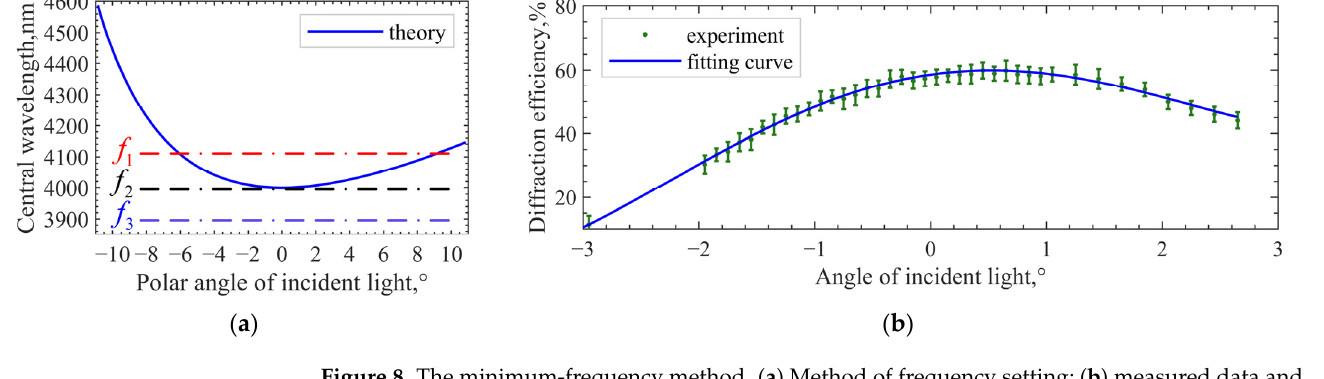
Figure 8. The minimum-frequency method. ( a ) Method of frequency setting; ( b ) measured data and fitting results.